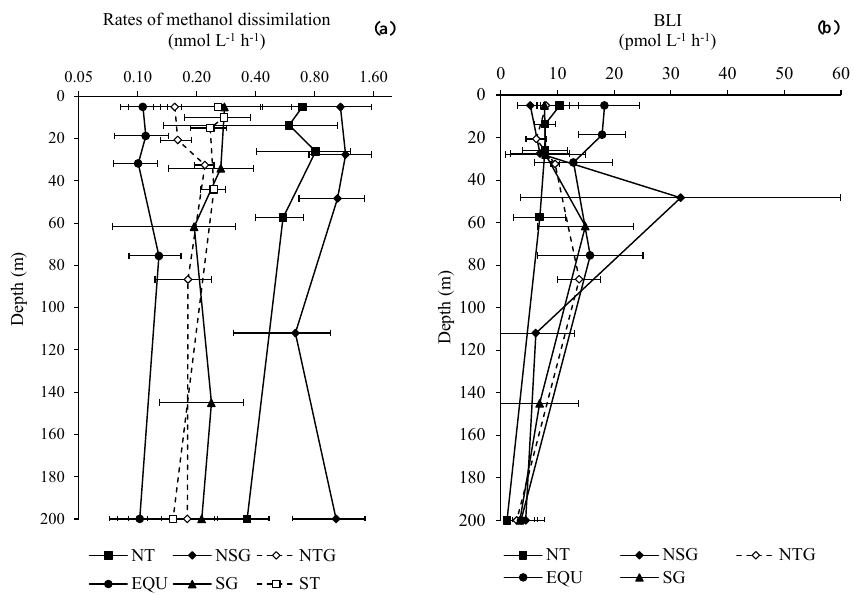
Figure 3. Average depth profiles in Atlantic provinces for (a) microbial methanol dissimilation (using the specific activity of 14 CH 3 OH) and (b) bacterial leucine incorporation (BLI) in pre-dawn waters. Error bars represent ± 1SD of variation within the province, province averages derived from NT ( n = 5), NSG ( n = 5), NTG ( n = 3), EQU ( n = 4), SG ( n = 5) and ST ( n = 3), except for BLI where there is no data from the